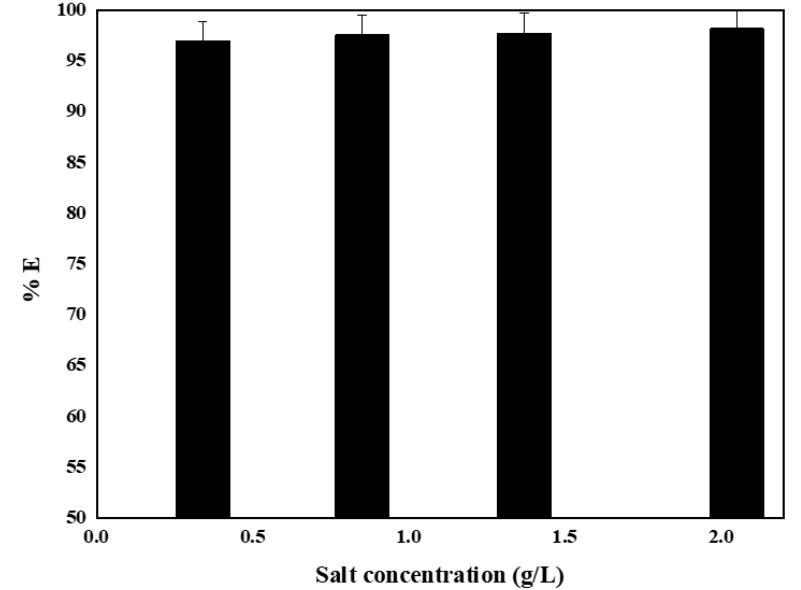
Figure 8. Effect of ionic strength on MB extraction. [MB] = 200 mg dm − 3 ; T = 25.0 °C.